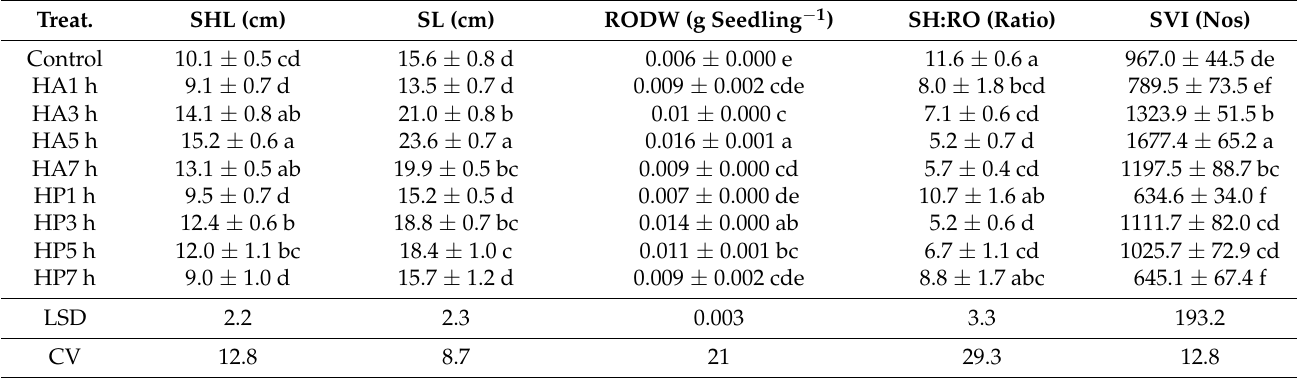
Table 5. Effect of priming treatments on seedling quality traits on the 7th day after sowing soybean seeds.